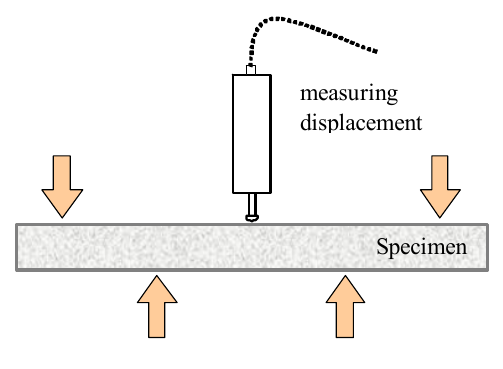
Figure 2. Four-point flexural test for mortar